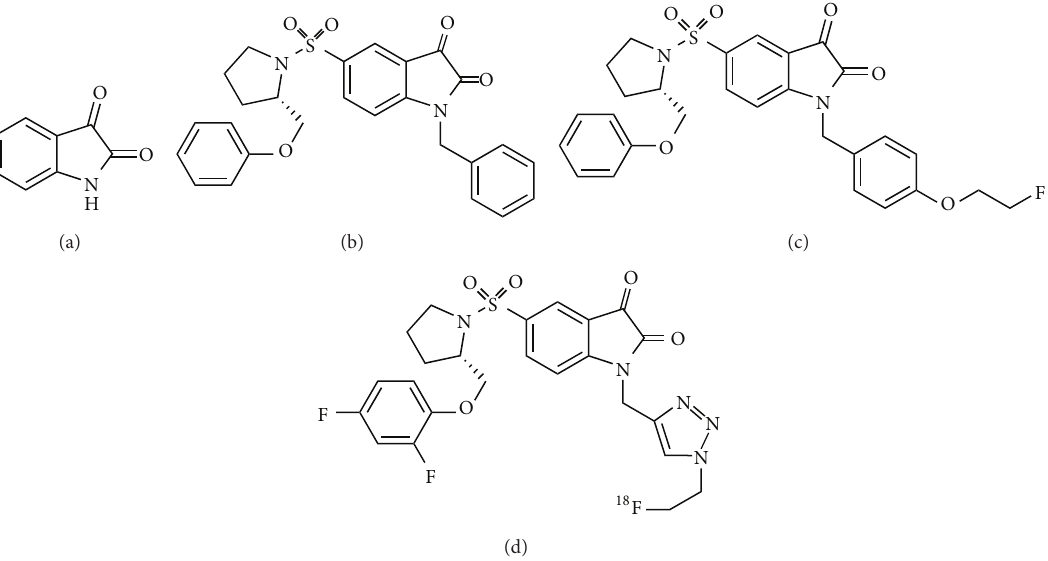
Figure 5: Structures of (a) Isatin, (b) ( S )-1-benzyl-5-[1-[2-(phenoxymethyl)pyrrolidinyl]sulfonyl]isatin, (c) WC-II-89, and (d) [ 18